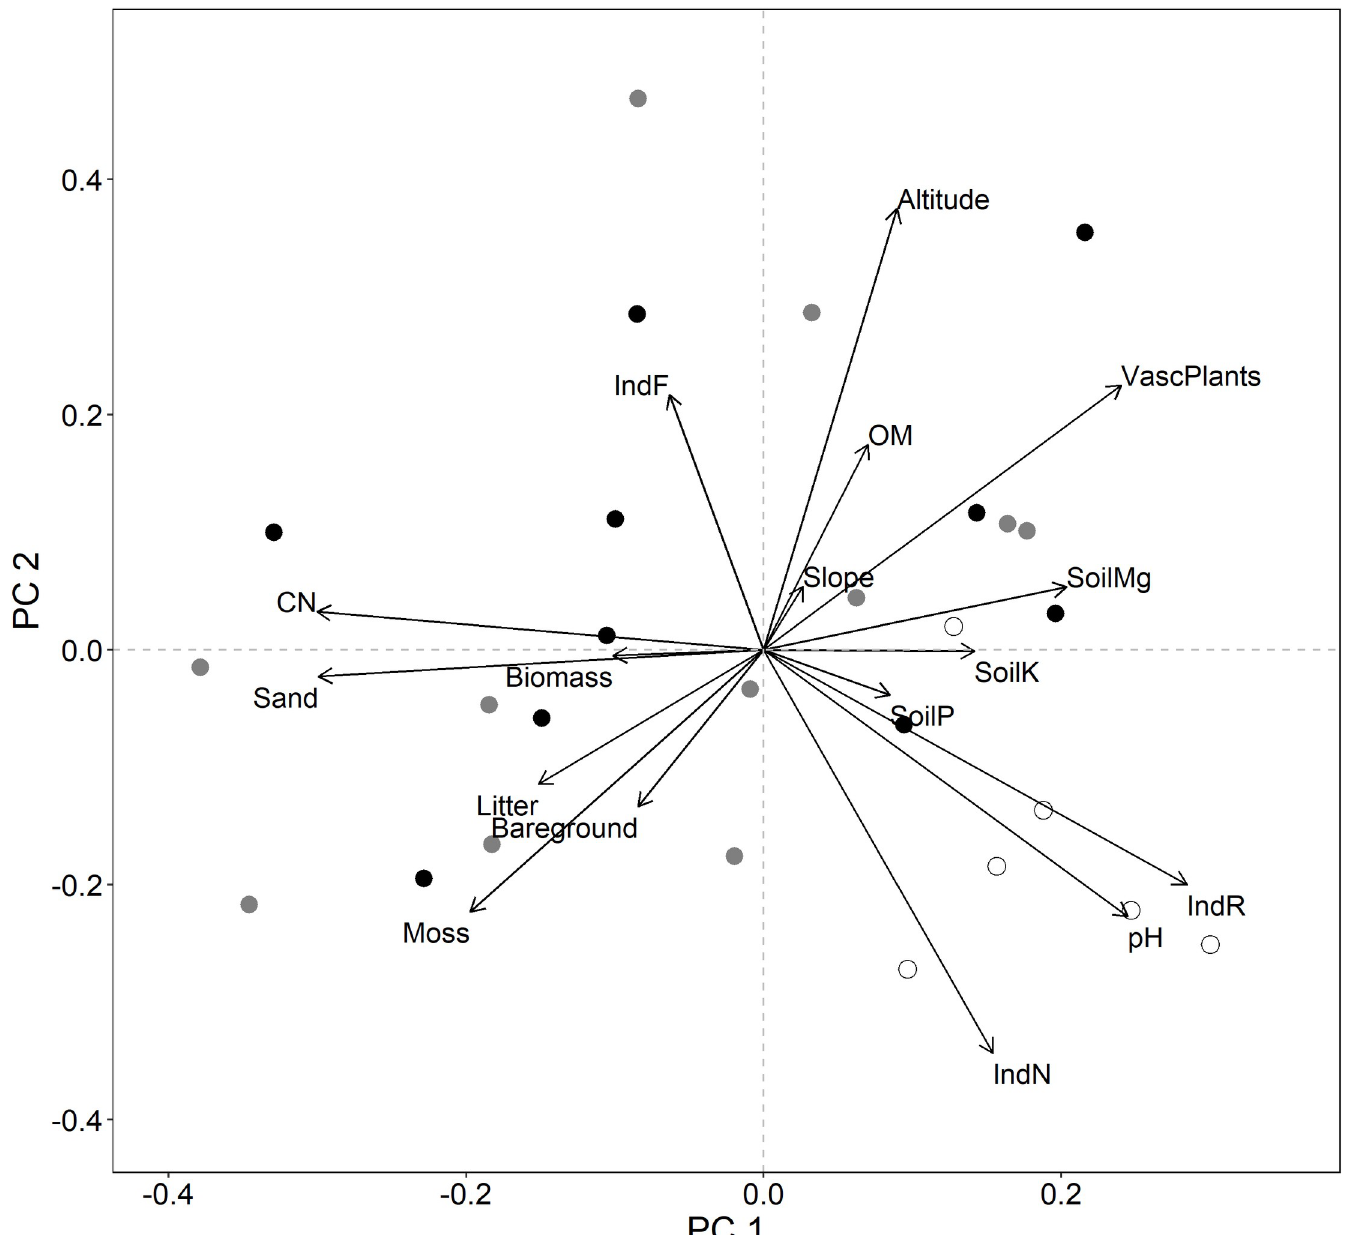
Fig 2. Biplot showing results of the PCA for abiotic and biotic variables from the field study. Topographic, soil, and vegetation parameters are shown as projection arrows onto the principal components. Extinct (white), small (gray) and large (black) A . montana population sites are displayed as objects. The first two principal components are displayed with 39.5% of variance explained (24.6%, 14.9%). As to present a complete overview of the data set, all variables remaining after removing highly correlated ones are shown; though not necessarily discussed in the text. The following abbreviations are used in the figure: OM–organic matter, CN–soil C:N ratio, IndR, IndF, IndN–Ellenberg indicator values for reaction, moisture and nitrogen; VascPlants–vascular plant biomass on 1 m 2